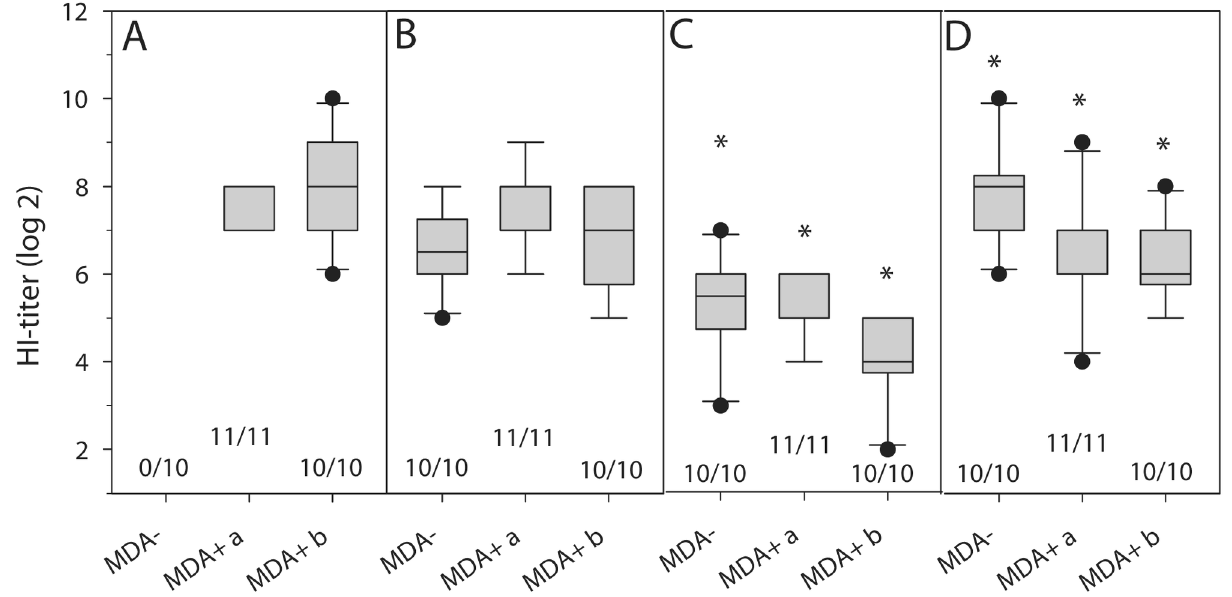
Figure 7. HI assay. Serum samples from immunized chickens before challenge collected at day 20 (MDA-) or 21 (MDA+) after vaccination with chNDVFHN H5 were tested for NDV (A), APMV-8 (B) and AIV H5 (C) specific antibodies by HI test. PMV8 Furthermore, serum samples of MDA- chickens and MDA+ chickens vaccinated at day one (MDA+a) or day 7 (MDA+b) after hatch, taken 14 dpch were tested for AIV H5 (D) specific antibodies by HI assay. The number of animals considered seropositive (HI titer > 2 log ) is given below box plots. Significant differences (P < 0.05) between C and D are marked by *. 2 doi: